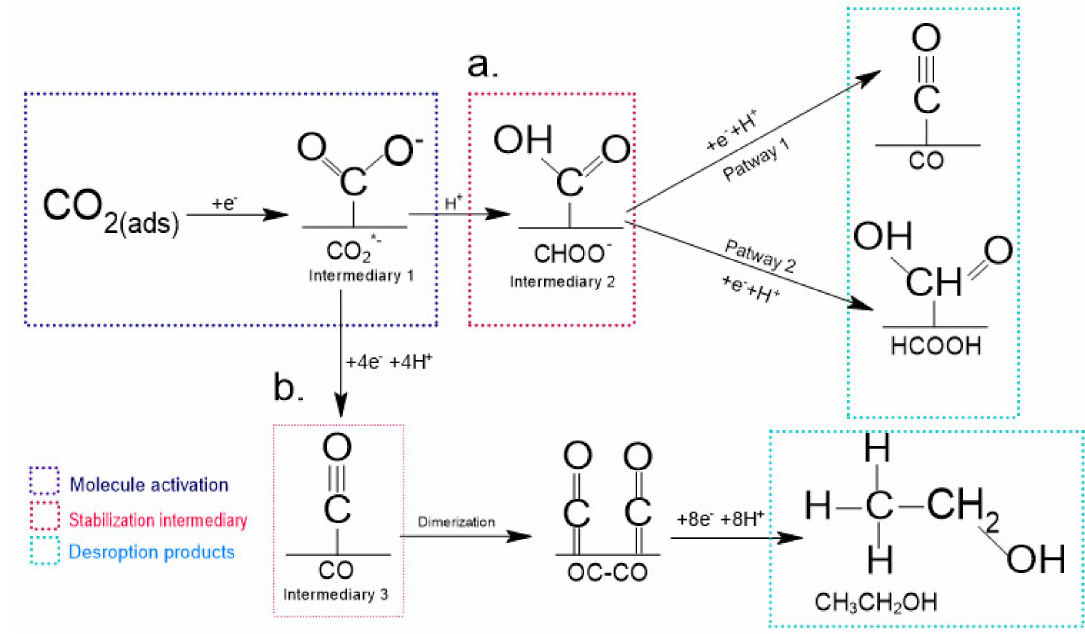
Figure 2. Selectivity and the reaction steps on N-doped metal-free catalysts ( a ) C1 type products, ( b ) C2 type